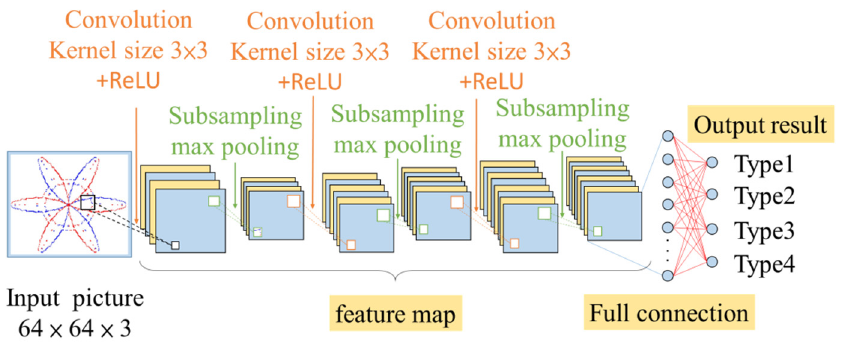
Figure 24. CNN model architecture .